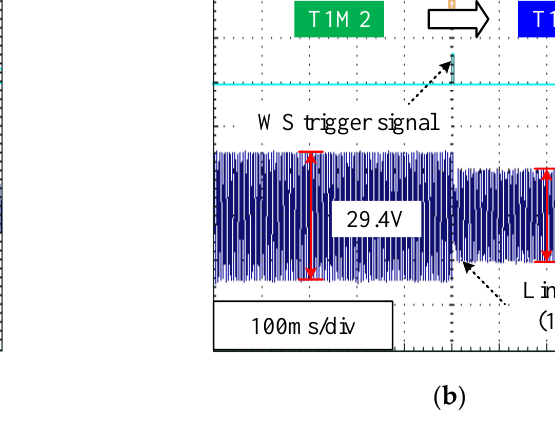
Figure 11. Characteristics of no-load back-EMF during the WS process. ( a ) From T1M1 to T1M2 at 500 rpm. ( b ) From T1M2 to T1M3 at 1000 rpm.